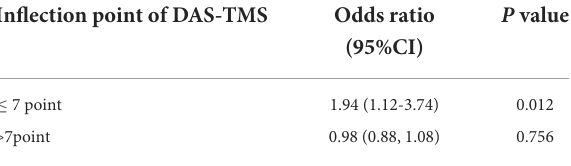
TABLE 3 Threshold effect analysis of DAS-TMS on the severity of postoperative symptoms using piecewise linear regression a . Inflection point of